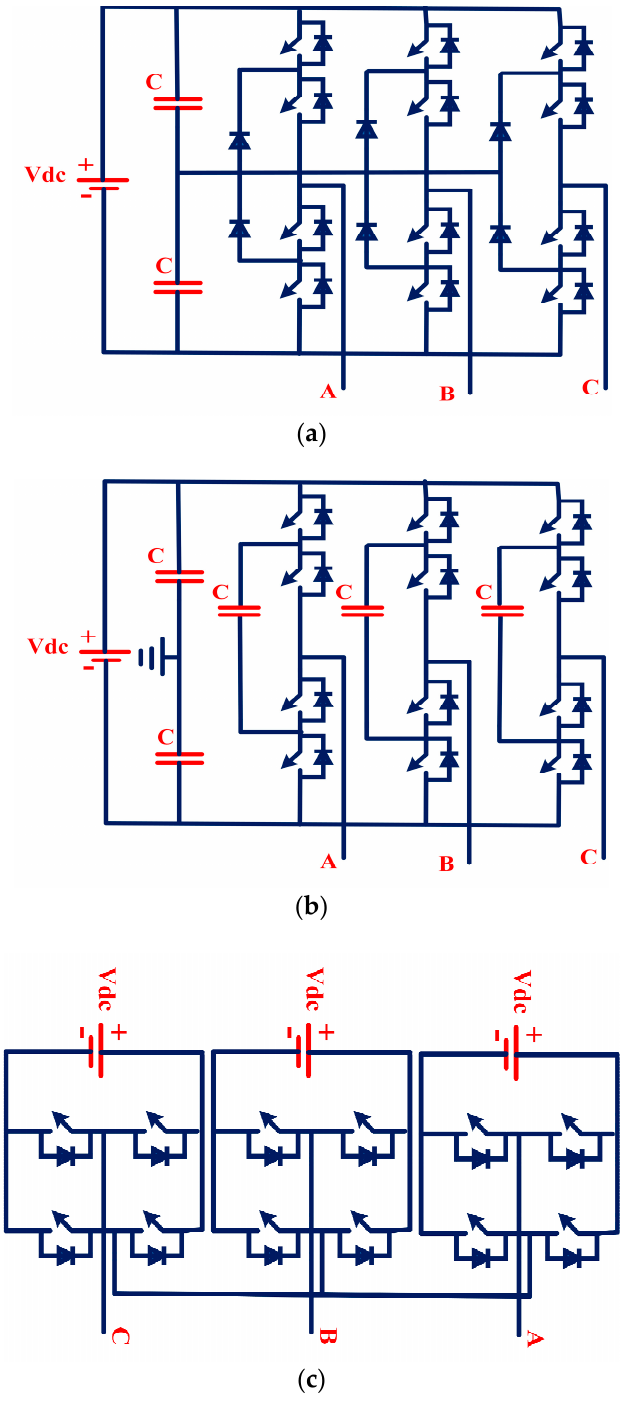
Figure 4. Circuit diagrams of multilevel inverters ( a ) NPC, ( b ) FC, and ( c ) CHB.